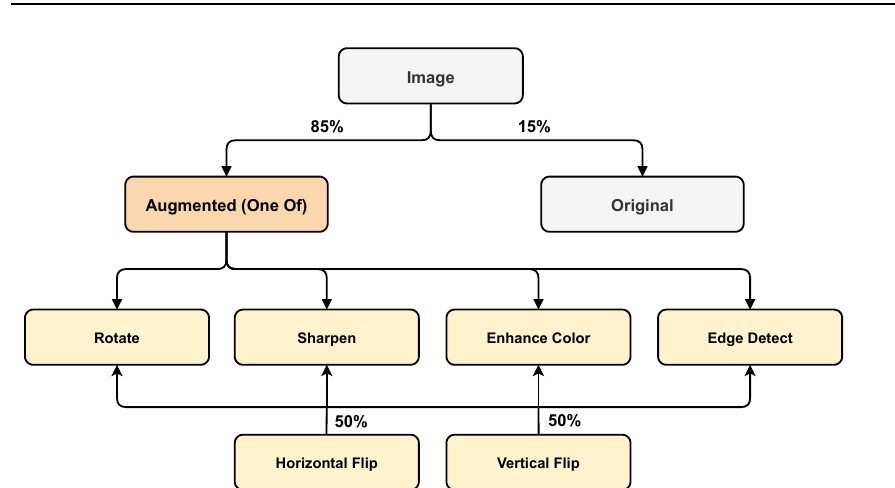
Figure 4. The selected augmentation